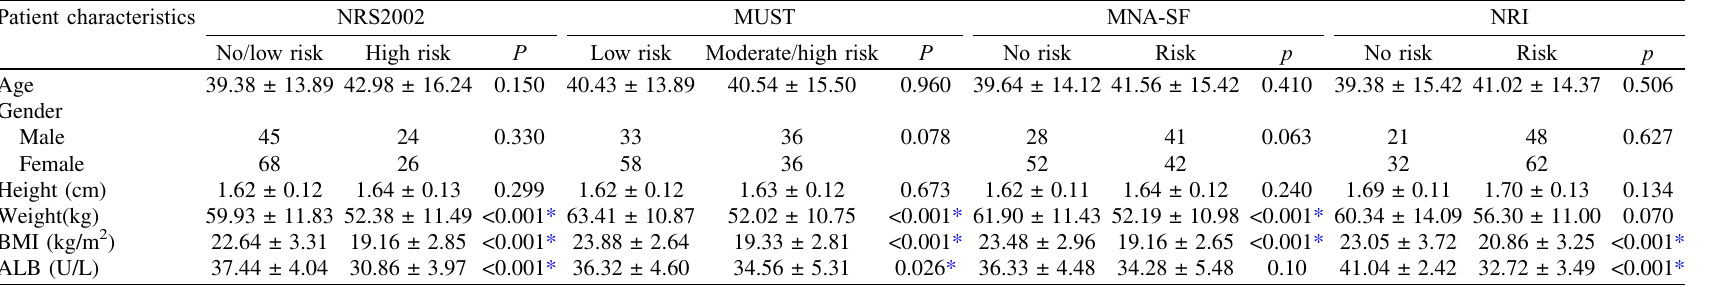
Abbreviations: BMI, Body Mass Index; ALB, Albumin; NRS 2002, Nutritional Risk Screening 2002; MUST, Malnutrition Universal Screening Tool; MNA-SF, Short Form of Mini Nutritional Assessment; NRI, nutrition risk index; ESPEN, European Society for Clinical Nutrition and Metabolism. * Values expressing statistical signi fi cance ( p (cid:3)